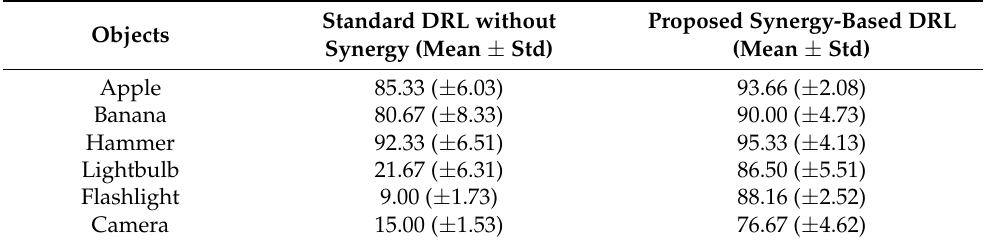
Table 2. The success rate (%) of grasping and relocating tasks using the standard DRL without synergy and the proposed synergy-based